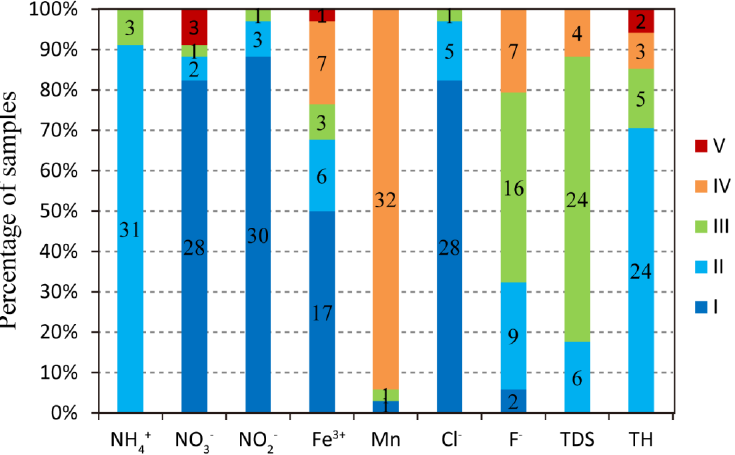
Figure 4. Percentage of the shallow groundwater samples for drinking purposes in five water quality categories.